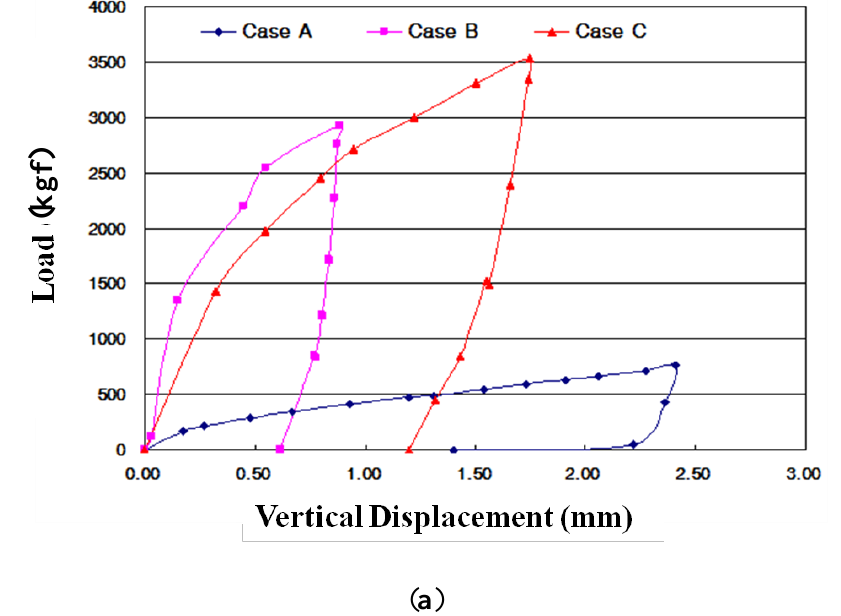
Figure 9. Vertical ( a ) and lateral ( b ) deformation of each